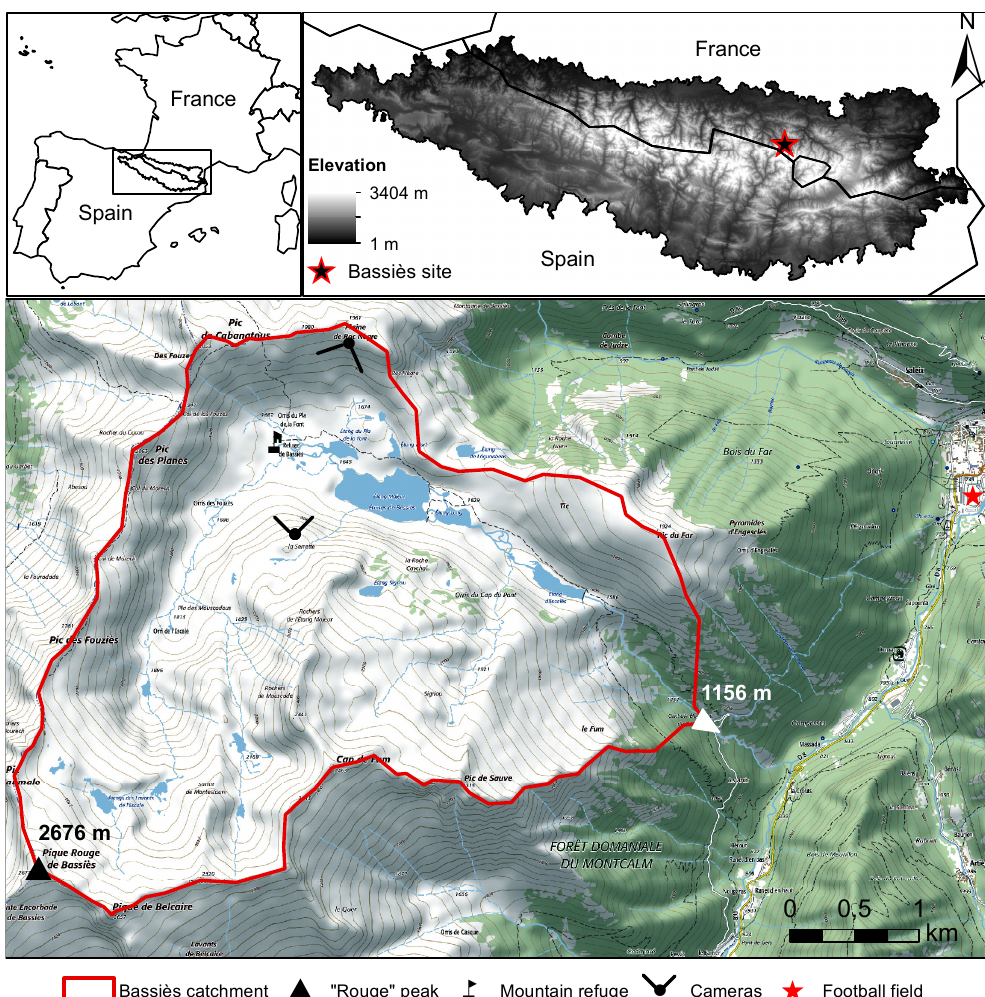
Figure 1. Top: localization of study site relative to Europe and to the Pyrenees mountain. Bottom: Bassiès catchment (14.5km 2 ) on a TOP25 topographic map © IGN (Institut national de l’information géographique et